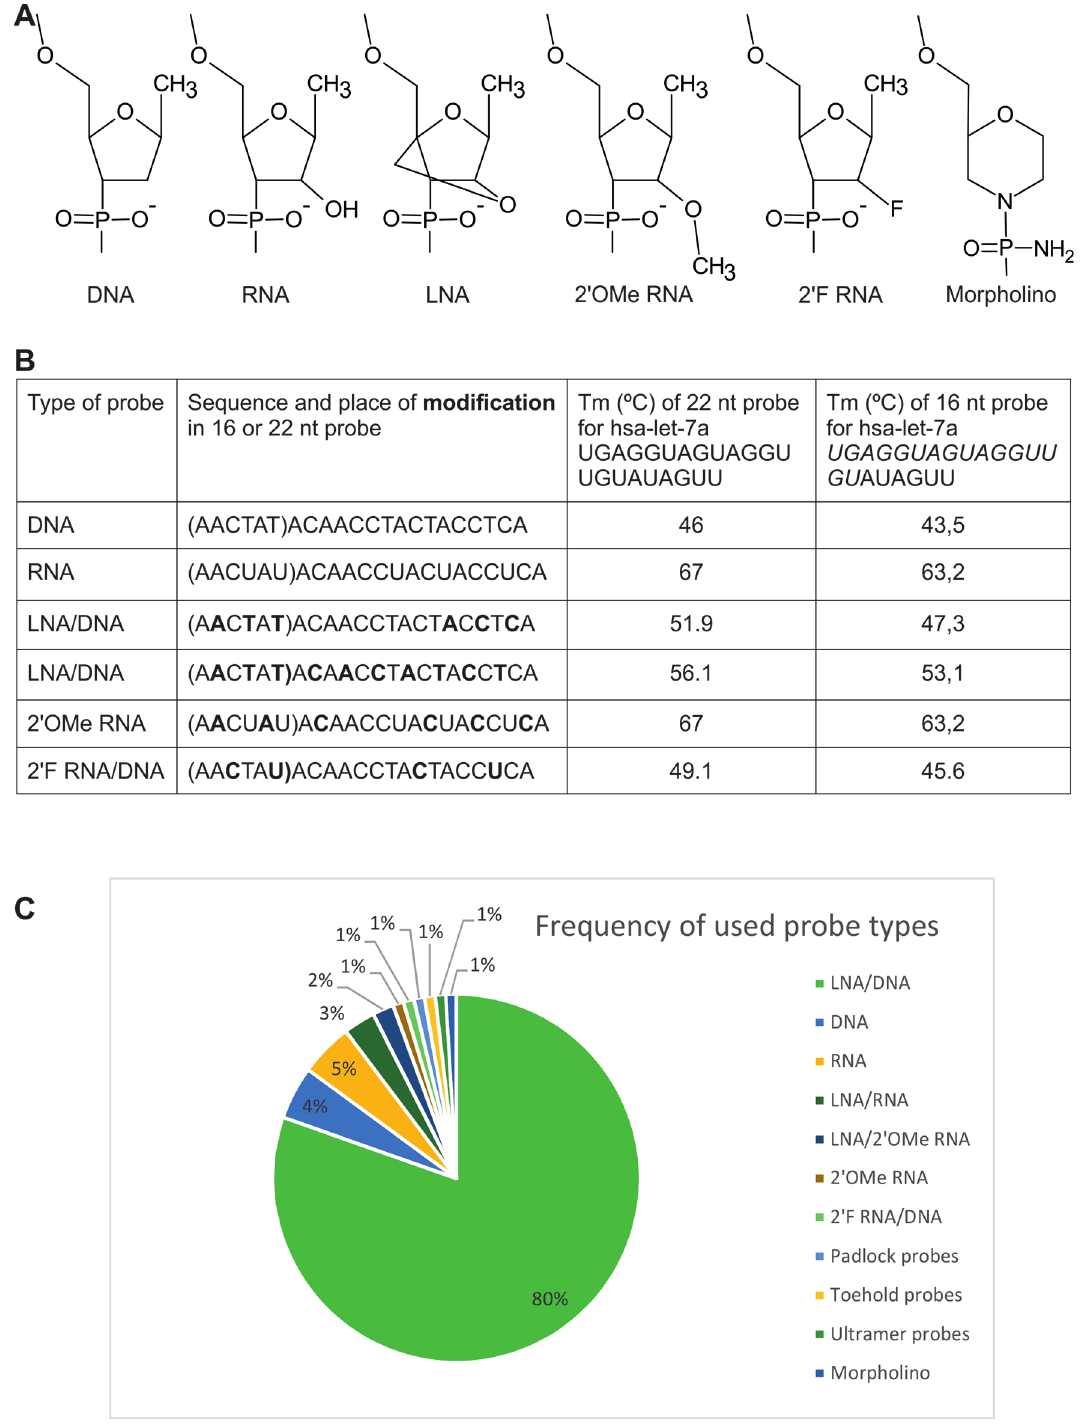
Figure 2. Types of nucleotide modifications used in small RNA ISH probes. ( A ) Chemical structure of modified nucleotides present in the probes; ( B ) Comparison of the melting temperature (Tm) of the 22 and 16 nt probes with different modifications (marked in bold) and RNA target (hsa-let-7a-1). Target sequence for shorter probe is marked in italic. The high melting temperature indicates strong binding with the target sequence. All Tm calculations were performed with IDT Technologies OligoAnalyzer 3.1; ( C ) Frequency of different types of probes used in small RNA